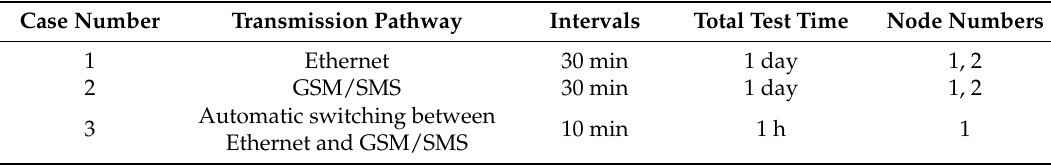
Table 1. Three test case scenarios.